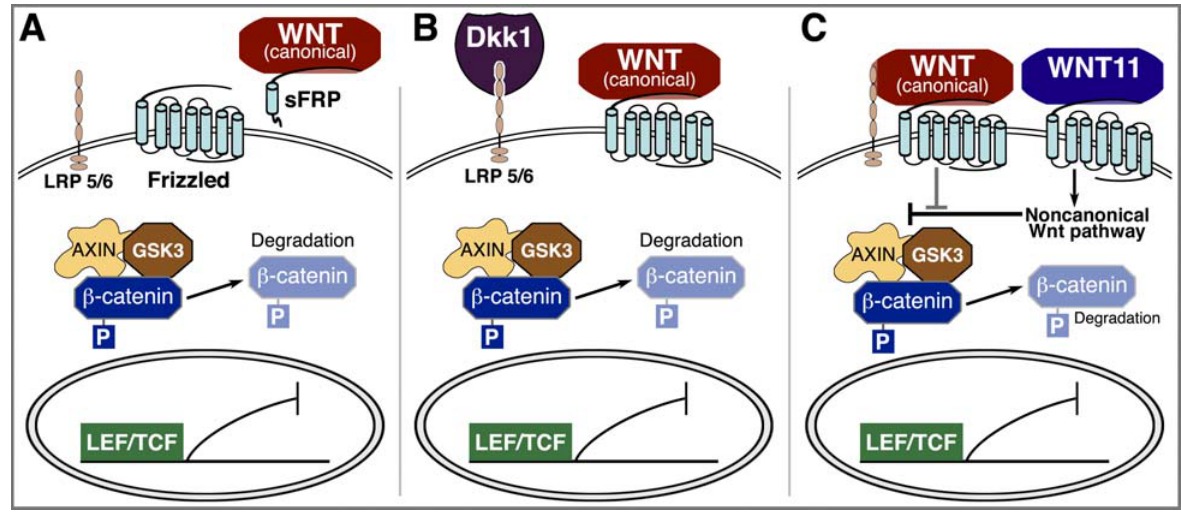
FIGURE 3. Multiple types of secreted, extracellular factors block canonical Wnt signal transduction. (A) sFRPs prevent Wnt binding to its cell membrane receptor frizzled by its competitive association with Wnt proteins. (B) Dkk1 interferes with the canonical Wnt pathway by binding to LRP5/6, which prevents Wnt proteins from interacting with this second class of Wnt receptors. (C) Noncanonical Wnt proteins (e.g., Wnt11) can inhibit the canonical Wnt pathway by downstream signal transduction events. Although the molecular details accounting for this suppression have not been well characterized, the activity of noncanonical Wnt signaling is known to prevent GSK3 inactivation by canonical